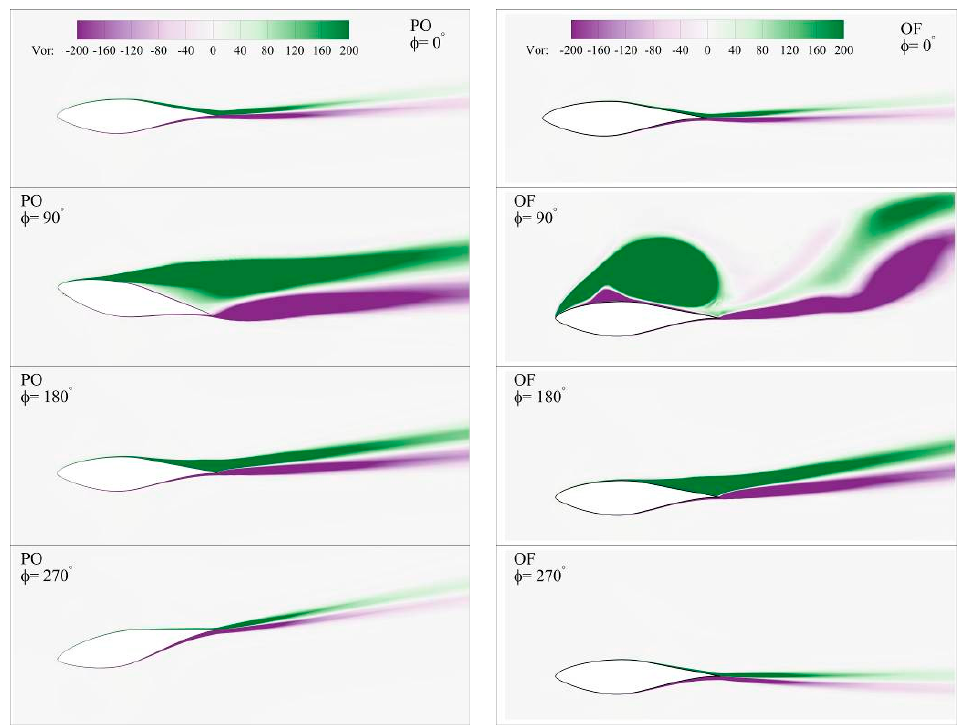
Figure 12. Vorticity contours of pitch oscillation and oscillating freestream at different phase angles. α m = 8°, A = 10° and k = 0.026 .